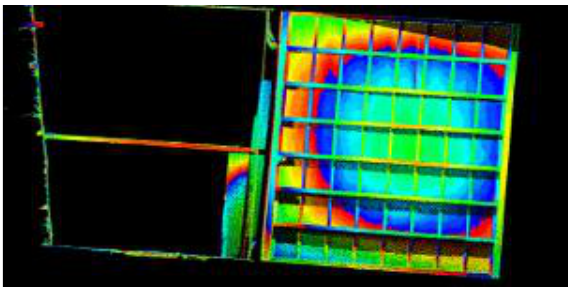
Figure 11 . Elevation Map highlighting ceiling deformations and areas of maximum